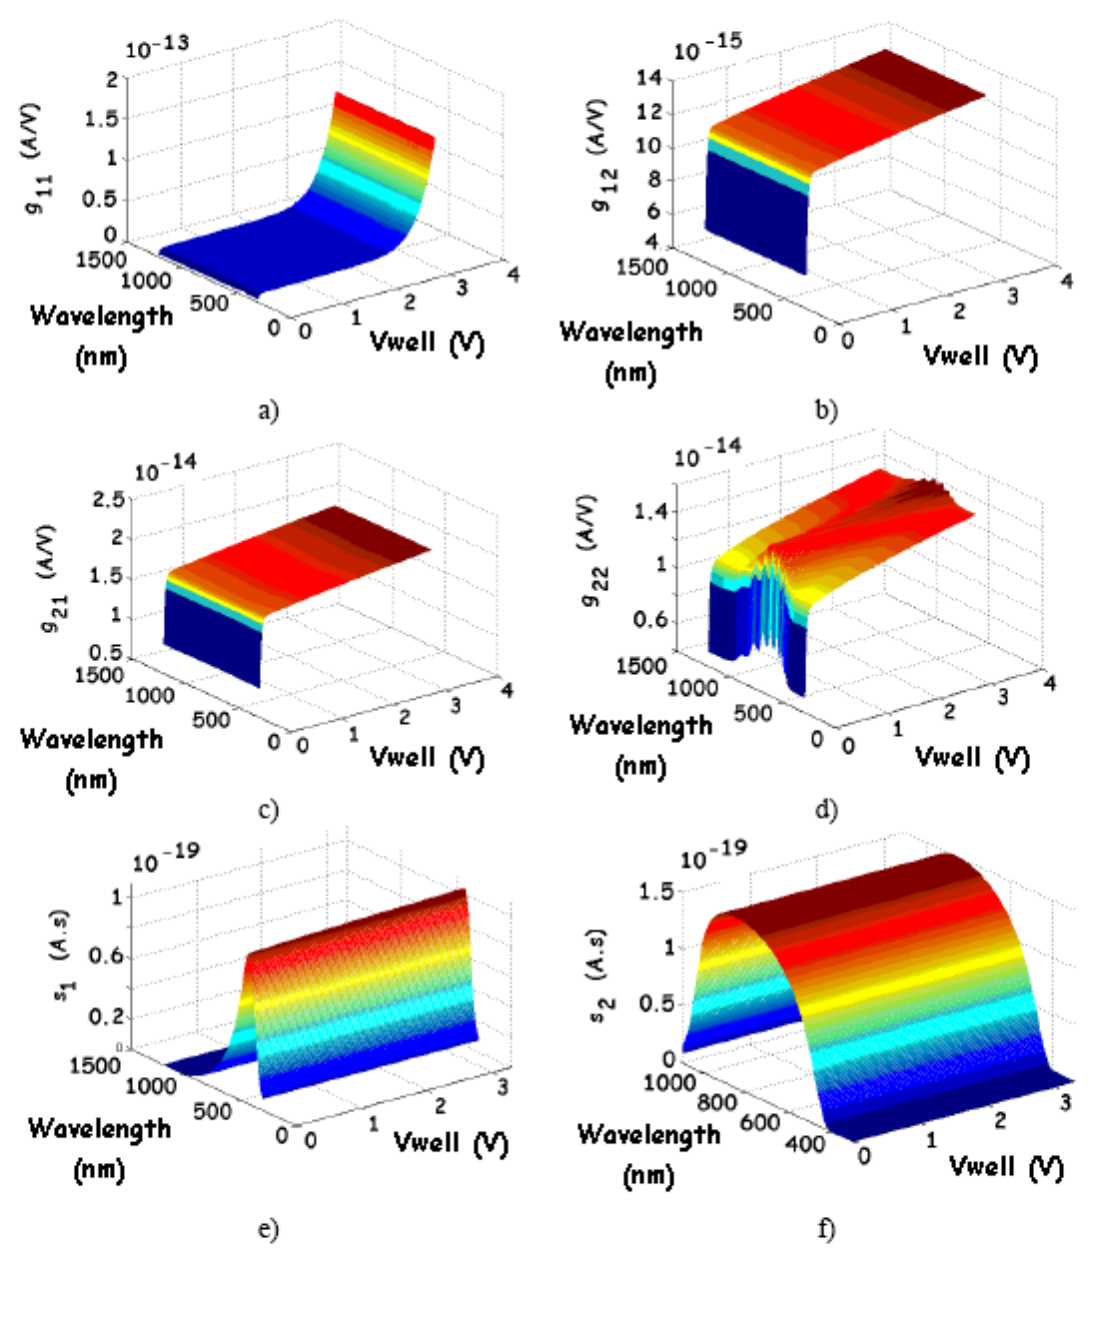
Figure 13. Simulated AC parameters of the BDJ PD (under the same conditions than in Figure